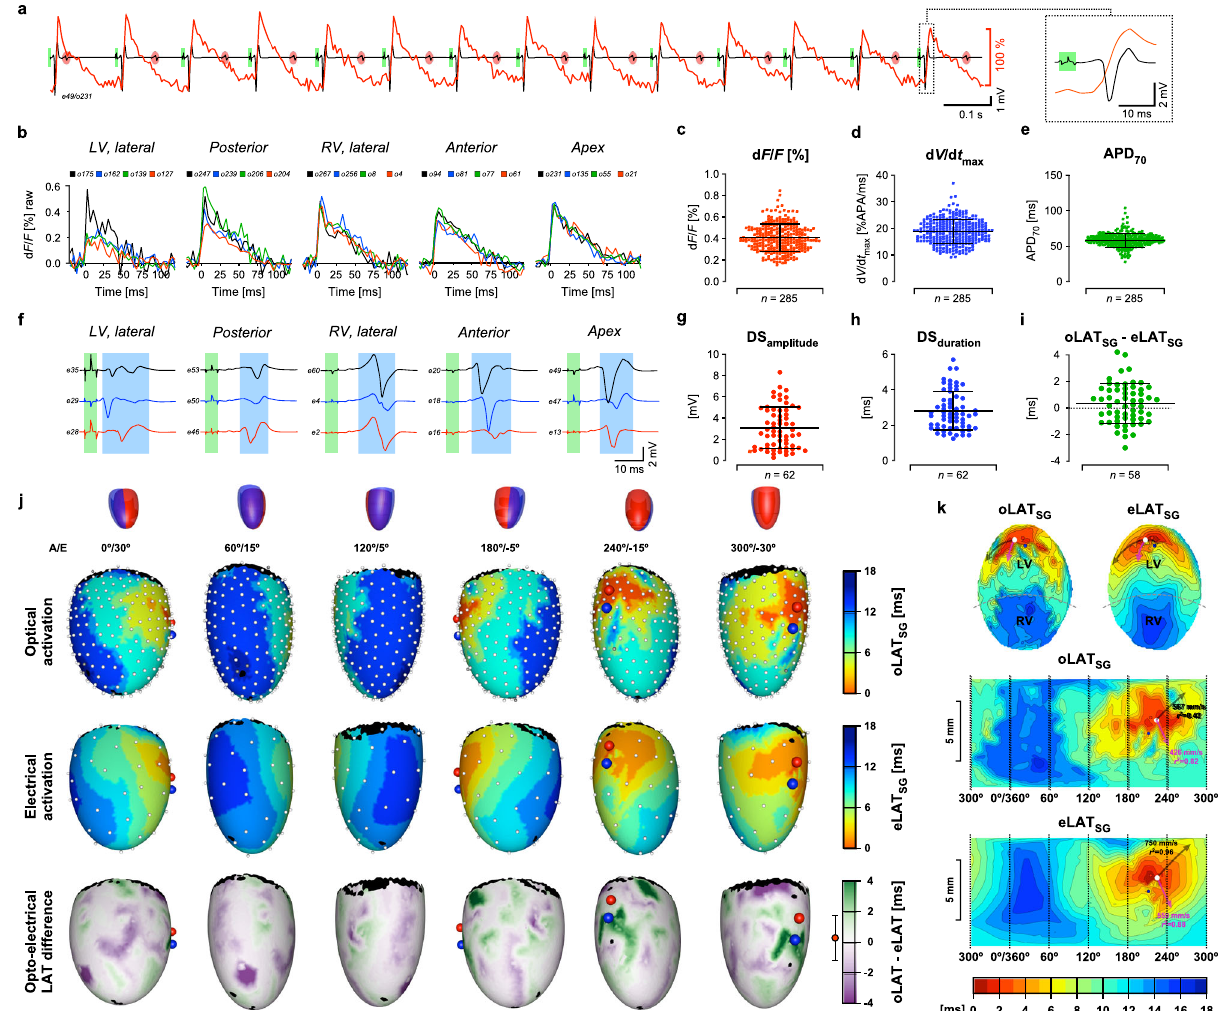
Fig. 4 Panoramic optoelectrical recordings of stimulated activation of a Myh6-Cre Tg /ASAP1 lox/wt heart. a Single fi ber optical signal overlaid on the electrogram of an adjacent electrode (red oval: atrial activity; green rectangle: stimulation artifact). The last activation is shown in expanded form on the right. b Un fi ltered optical action potentials (oAPs) recorded by a selection of optical fi bers in contact with different regions of the heart. c Fractional fl uorescence change (d F / F ) of oAPs. d Maximal upstroke velocities (d V /d t max ) of oAPs. e Duration of oAPs determined at 70% of repolarization (APD 70 ). f Electrograms recorded from the regions of the heart indicated (green bands: stimulation artifact; blue bands: local electrogram). g Distribution of downstroke (DS) amplitudes and h downstroke durations of the electrograms recorded during a single ventricular activation. i Distribution of local differences between oLAT SG and eLAT SG . j Schematic of heart orientation (A: angle; E: elevation; red: left ventricle; blue: right ventricle) with corresponding 3D maps of the optically determined activation sequence (top), electrical activation (center), and the differences between optically and electrically determined local activation times (oLAT − eLAT) (bottom; mean ± SD shown on the left of the color bar; n = 58). The location of the stimulation electrode pair is indicated by a red and blue sphere, respectively. k Central- and Mercator projections of ventricular activation determined optically (oLAT SG ) and electrically (eLAT SG ). White discs: site of initial activation; black arrow: direction of fastest activation; red arrow: propagation perpendicular to the black arrow (arrow lengths are scaled to the conduction velocities). “ n ” refers to the number of signals produced by the recording sites during a single activation of the heart. Error bars refer to ±SD. Source data are provided as a Source Data fi activation lasted for 23.1 ms (optical) and 19.5 ms (electrical). The 3D, central-, and Mercator projections of ventricular activation depicted in Fig. 3k show that excitation elicited at the location marked with a white sphere spread preferentially in latero-apical direction with maximal conduction velocities ( θ ) measured optically ( θ o ) of 830 mm/s and electrically ( θ e ) of 753 mm/s. Conduction velocities determined in perpendicular direction reached 390 mm/s ( θ o ) and 350 mm/s ( θ e ) resulting in anisotropy ratios of 2.13 and 2.15 for optical and electrical recordings, respectively.